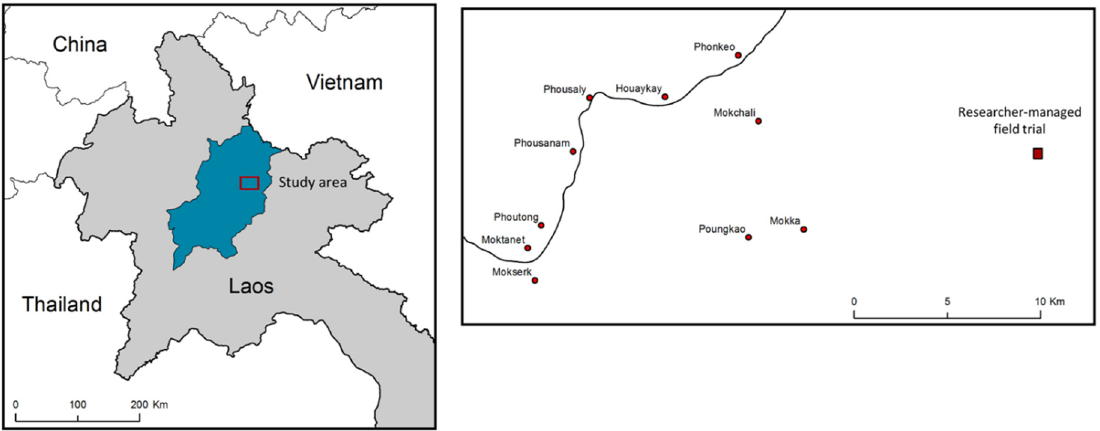
Figure 1. Map of the study area located in northern Laos.